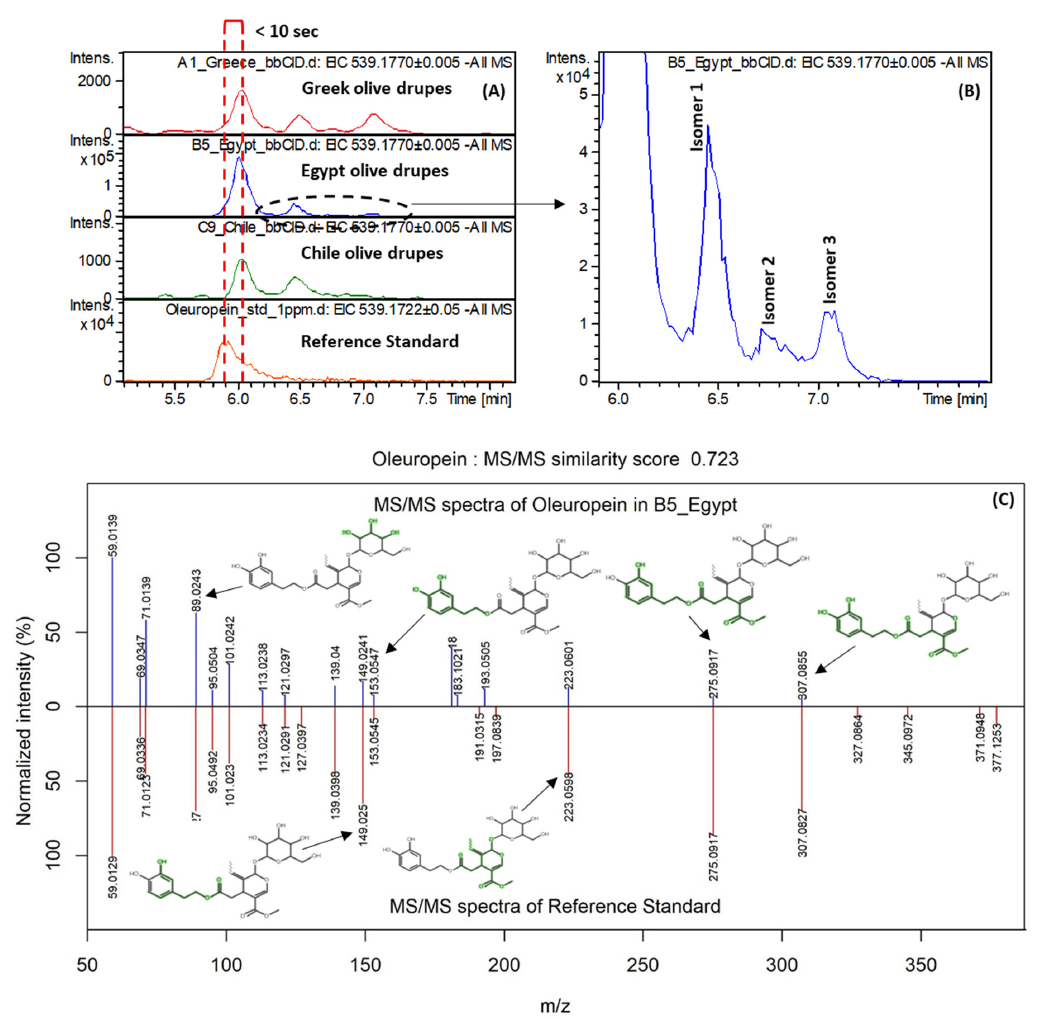
Figure 6. ( a ) EIC of oleuropein for representative samples from each geographical origin and reference standard; ( b ) isomers of oleuropein detected in olive drupes; ( c ) MS/MS match between oleuropein in the samples and its reference standard.